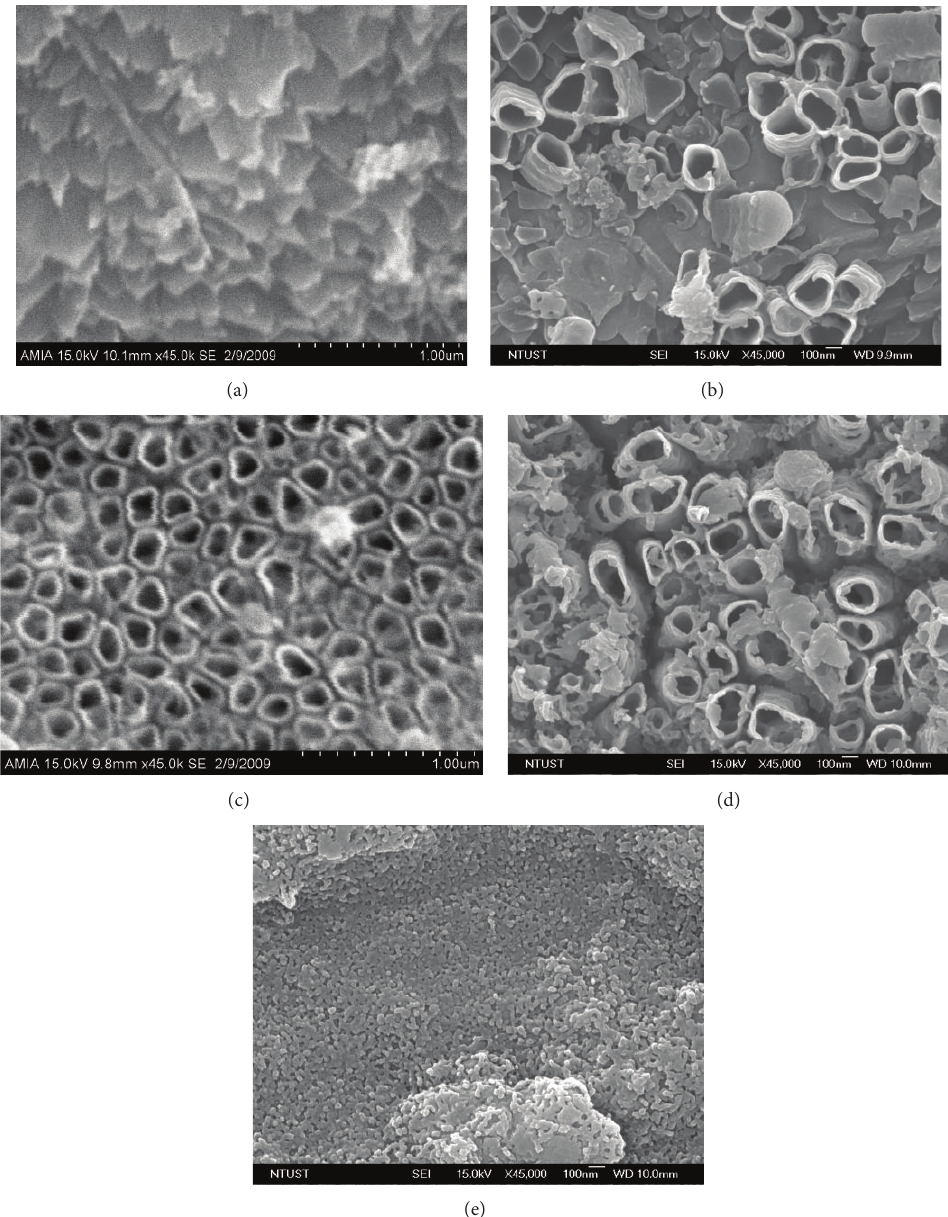
Figure 8: Top view of SEM images of TNT synthesized at different electrolyte solution pH: (a) 2, (b) 4, (c) 6, (d) 8, and (e)